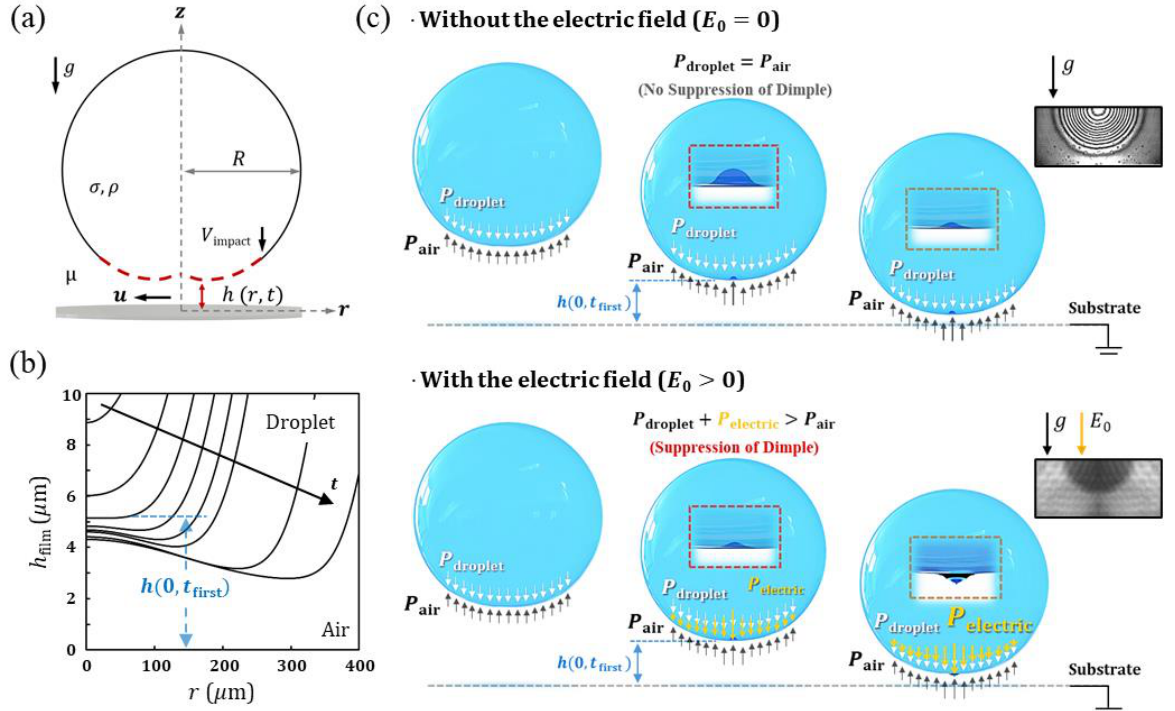
Figure 1. The suppression of a dimple (air film layer) on the electrified droplet surface. ( a ) A schematic of the droplet for numerical analysis, ( b ) The development of air film during the coalescence of a droplet and the height of interface, h ( 0, t first ) when a dimple is firstly formed, and ( c ) The sequence of the dimple formation and h ( 0, t first ) with and without electric field.